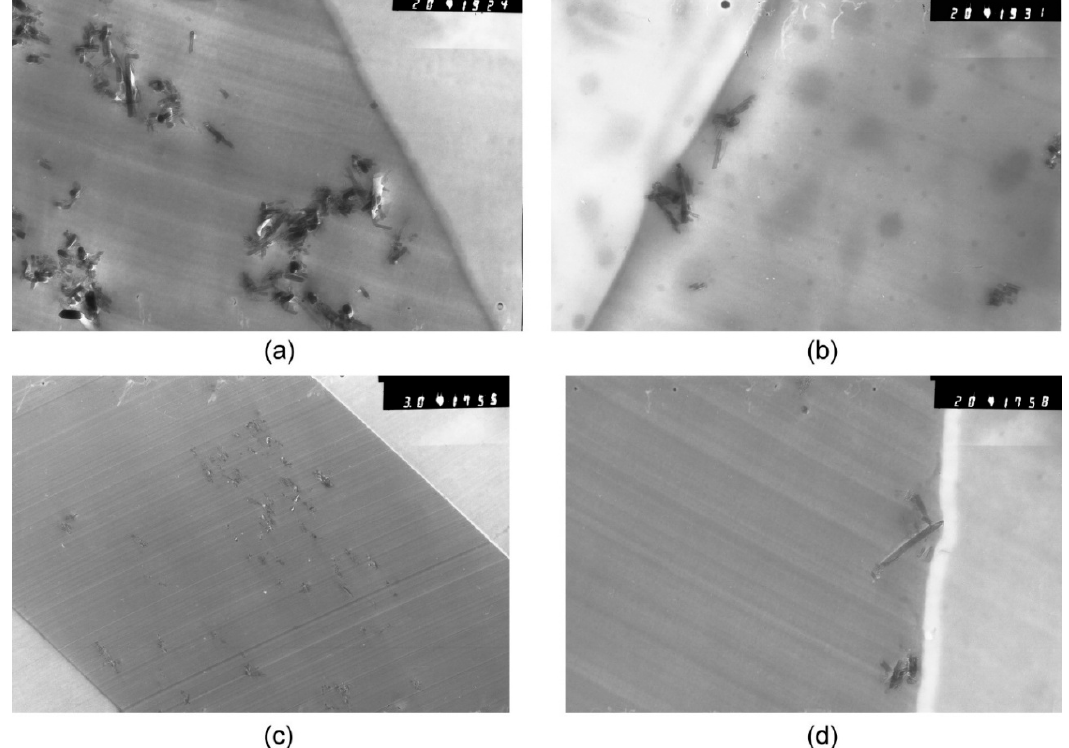
Figure 25. Photomicrographs of ultra—thin cross—cuts for ( a , b ) PAI-1-SNT-II and ( c , d ) PAI-2-SNT-II. Magnifications: ( a , b , d ) 2000; ( c ) 3000 [121].